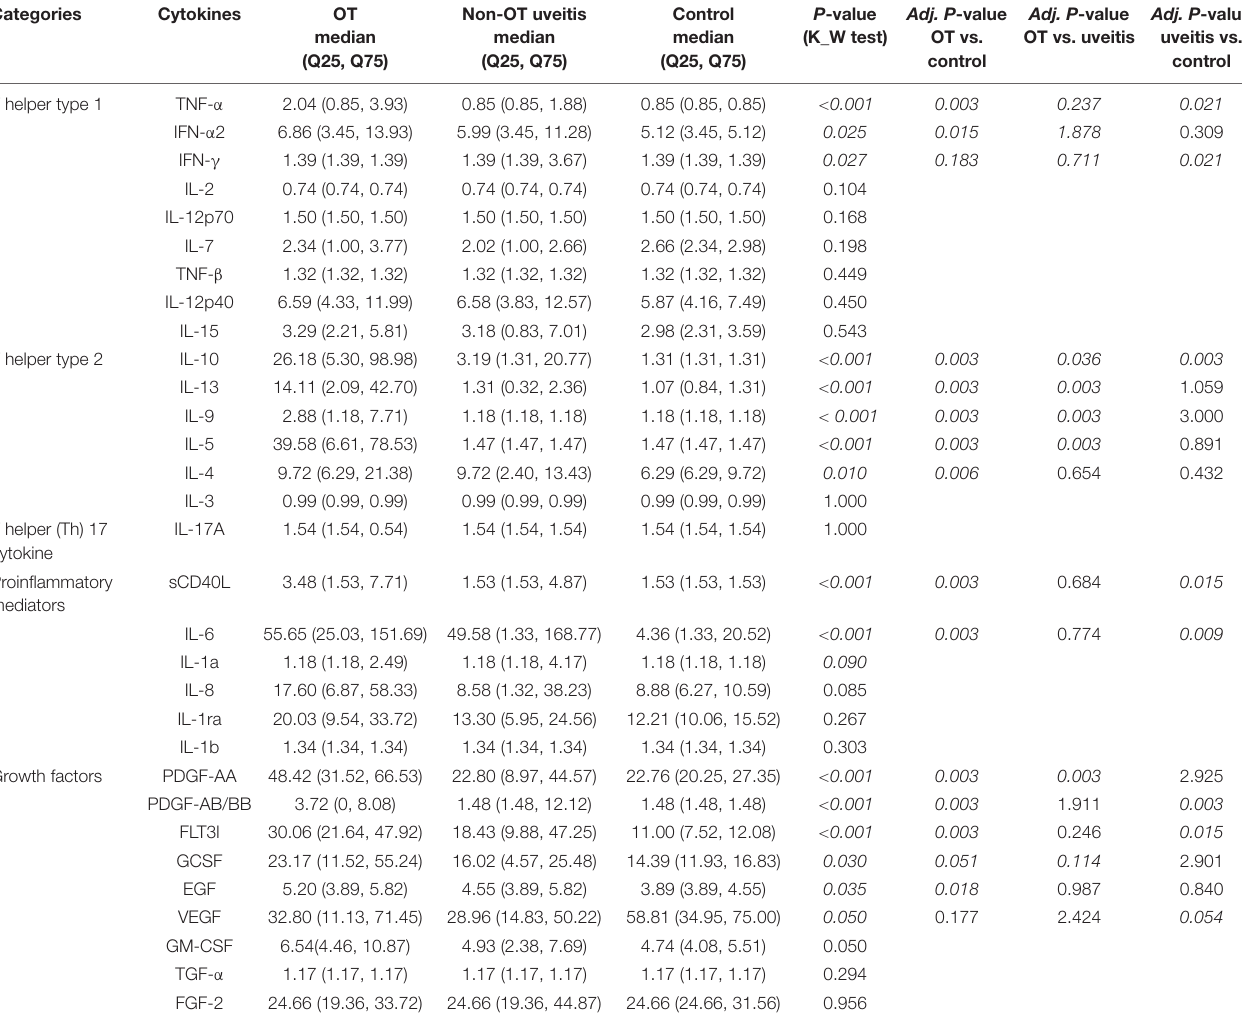
TABLE 1 | Summary of cytokines measured by multiplex bead immunoassay